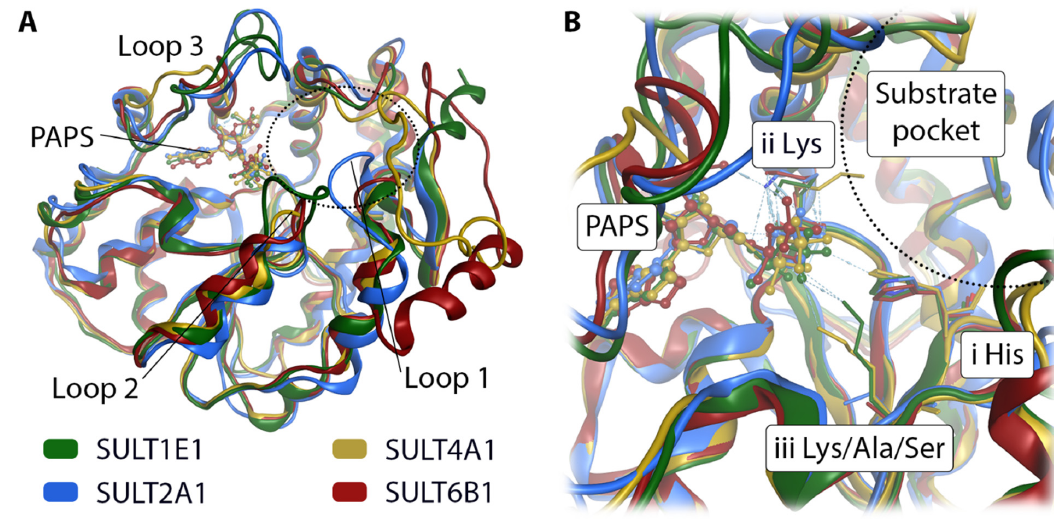
Figure 7. Superposition of four SULT isoforms with cofactor PAPS. SULT1E1 and SULT2A1 are X-ray structures taken from the PDB. SULT4A1 and SULT6B1 are homology models. ( A ) The view of the full structures shows deviations in three loops contributing to the binding site. ( B ) A closer look at the catalytic site shows the position of the conserved catalytically relevant histidine (i His). A lysine (ii Lys) is located in the vicinity of the substrate pocket (indicated by a dotted semicircle), while the second lysine is only present in SULT1E1 and SULT4A1 (iii